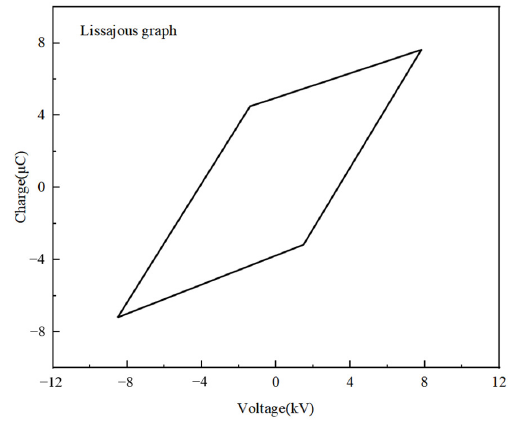
Figure 12. Lissajous graphic.